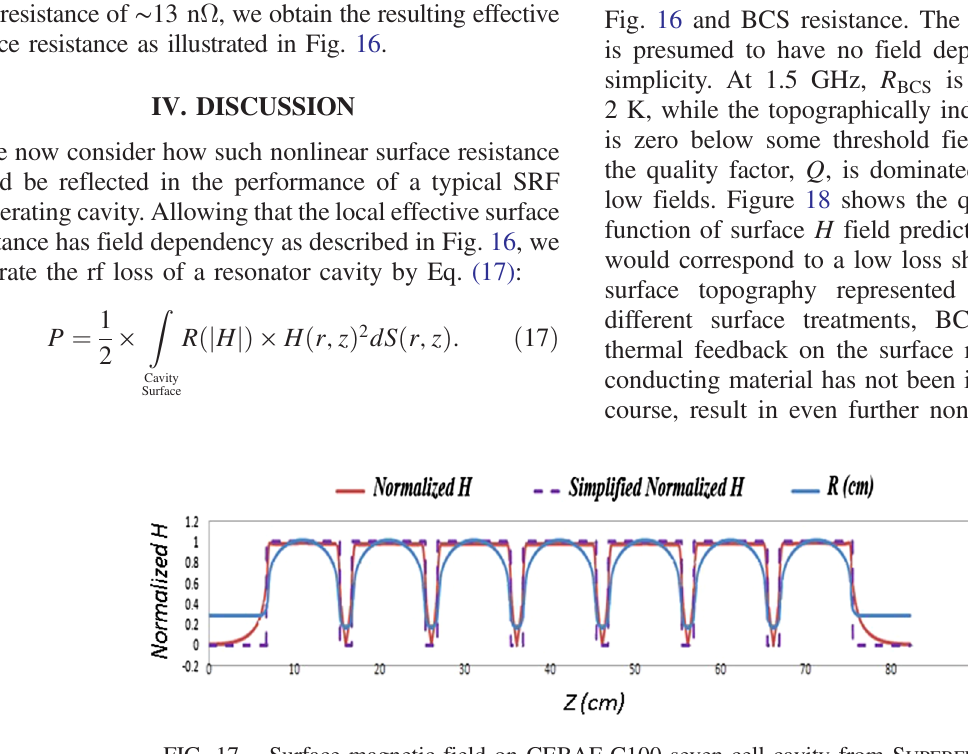
FIG. 17. Surface magnetic field on CEBAF C100 seven-cell cavity from S UPERFISH